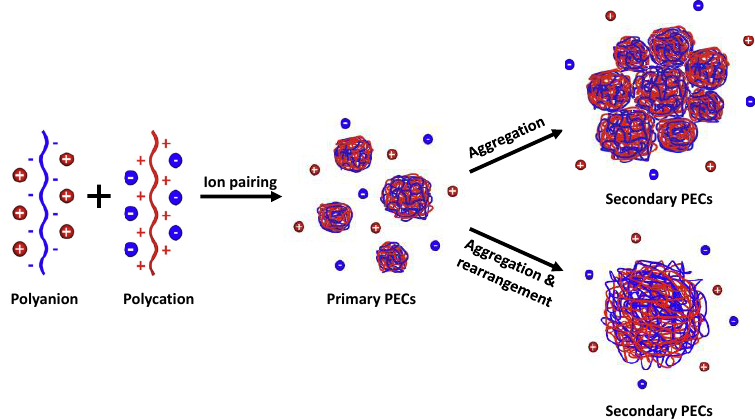
Figure 1. Two-step mechanism of PEC particle formation. The morphology of the secondary com- plexes depends on the hydrophobicity of the PEs, with highly hydrophobic PEs favoring a rasp- berry-shaped morphology and hydrophilic PEs leading to a more homogeneous structure (adapted from [16]).